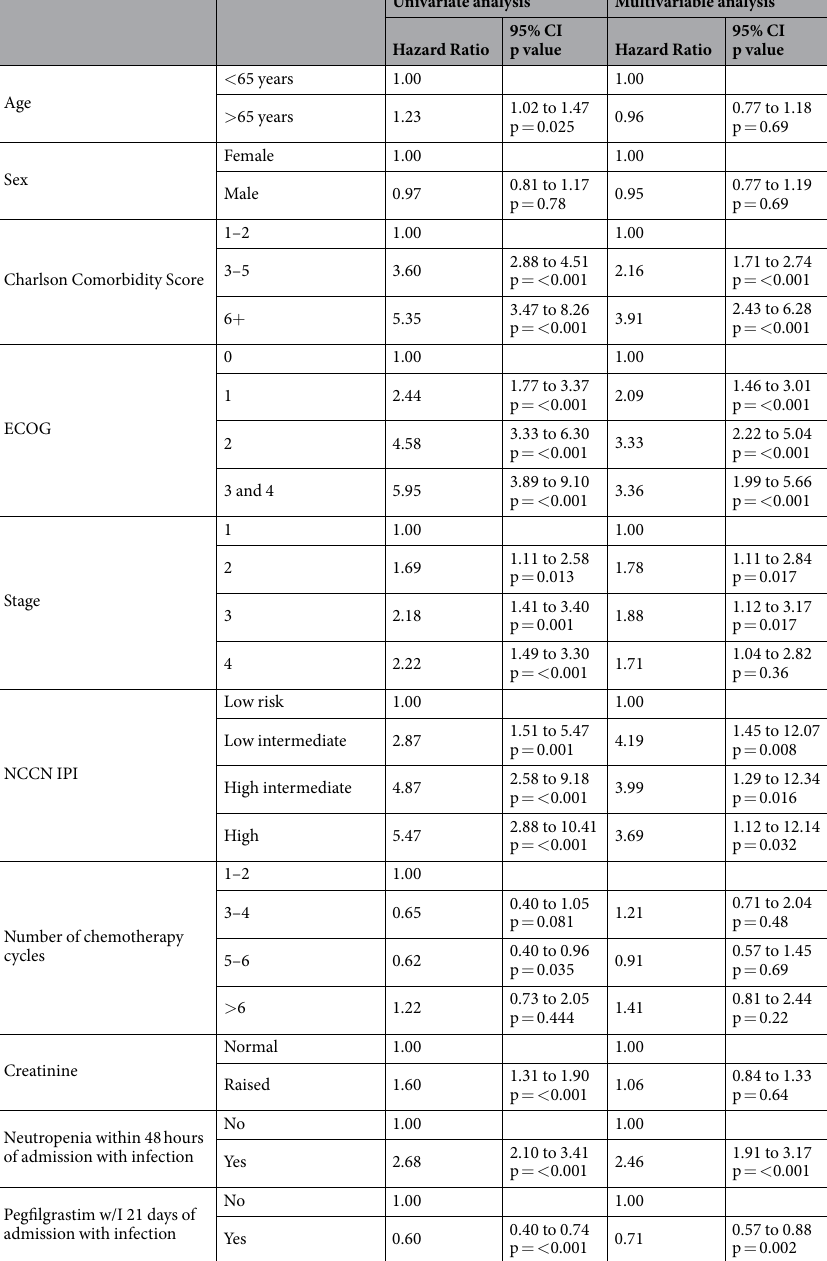
Table 4. Regression analysis of the factors associated with infection in all study patients (n = 325). ECOG = Eastern Cooperative Oncology Group performance status point scale. NCCN-IPI = International Prognostic